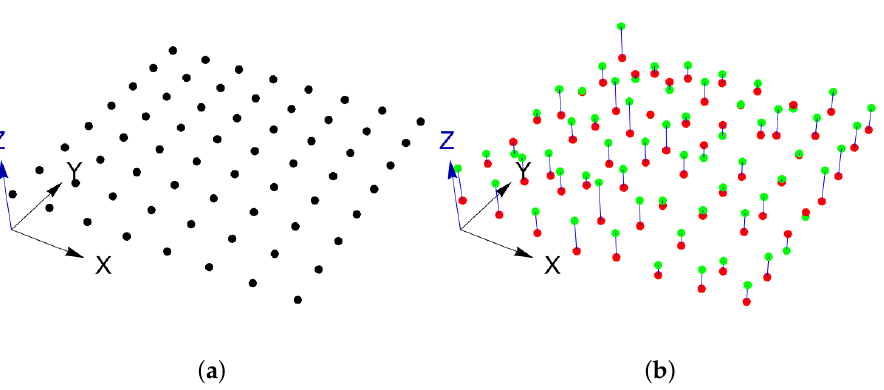
Figure 3. The graphical explanation of fitness evaluation based on surface topography. ( a ) Regular grid of points. ( b ) Point-by-point differences between two surfaces projected onto the regular grid.